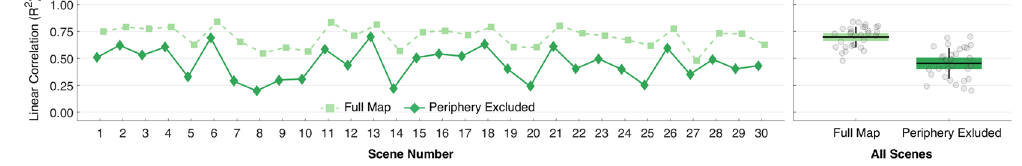
Figure 2. Correlation (R 2 ) between saliency and meaning maps. The line plots show the correlation between the meaning and saliency maps for each scene. The scatter box plots on the right show the corresponding grand correlation mean across N = 30 scenes (black horizontal line), 95% confidence intervals (colored box), and 1 standard deviation (black vertical line). The top (light) line shows the full correlation and the bottom line shows the correlation with center bias removed. The mean correlations differed significantly from zero, p < 0.0001.